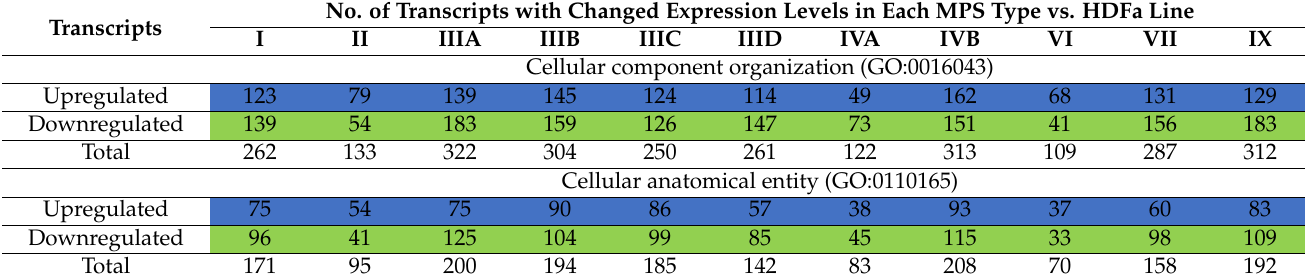
Table 1. Number of up- and downregulated transcripts (at FDR < 0.1; p < 0.1) of genes included into GO terms ‘Cellular component organization’ (GO:0016043) and ‘Cellular anatomical entity’ (GO:0110165) in different types of MPS relative to control cells (HDFa).